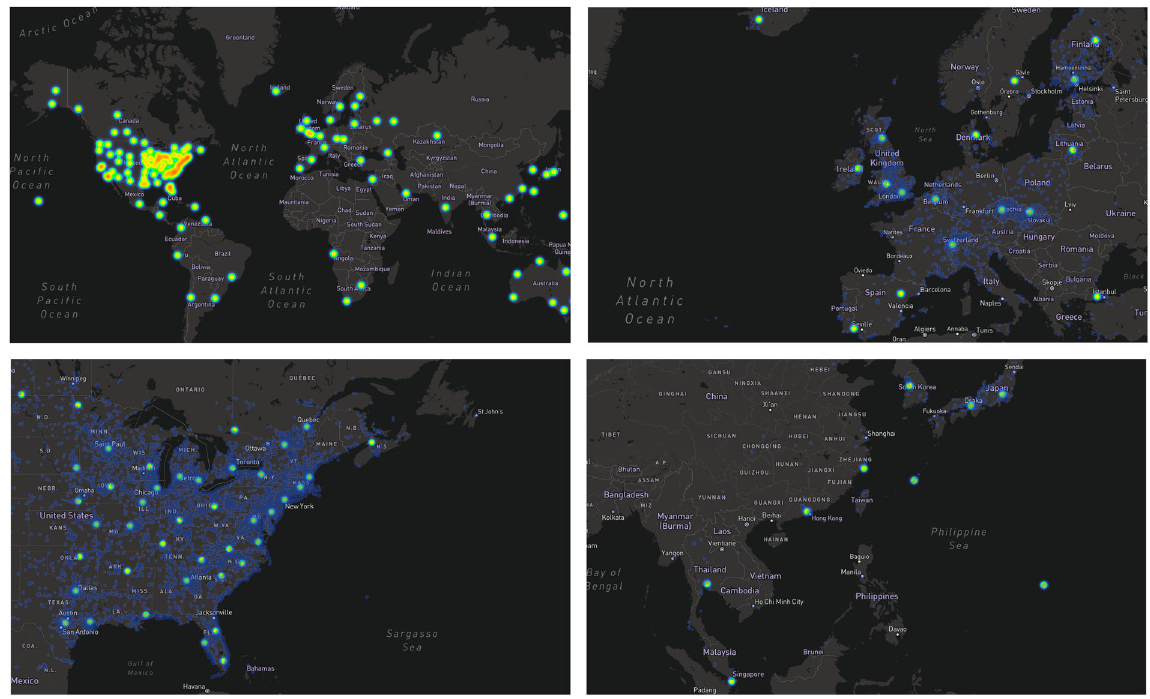
Fig. 5 International geospatial characterization of BrAC self-monitoring hot spots using a smart breathalyzer. The dynamic web-based version of this map can be explored by downloading Supplementary Figure 3 and dragging it into a browser window. The green dots represent “ hot spots ” , or centroids representing clusters of high-density activity, obtained by conducting a K-means analysis on the latitude and longitude of the observations. Blue-purple coloring represents the density (or number) of the actual observations, which become visible upon zooming in further. This map was generated using the Mapbox API (San Francisco, CA) application programming interface, with permission.